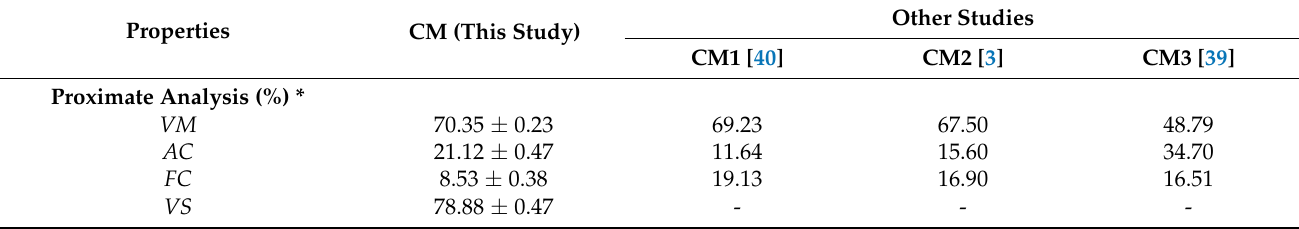
Table 1. Results of proximate, ultimate, and heating value analysis for raw chicken manure in the current and previous